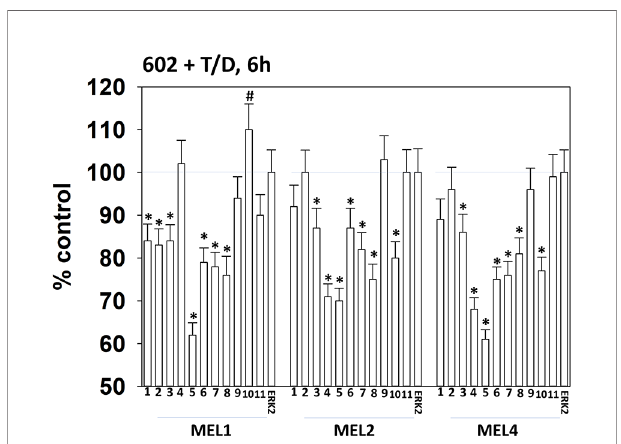
FIGURE 10 | Exposure of cells to [GZ17-6.02 + trametinib + dabrafenib] reduces the expression of multiple HDAC proteins. Melanoma cells were treated with vehicle control or [GZ17-6.02 [curcumin (2 µM) + isovanillin (37.2 µM) + harmine (4.5 µM)] + trametinib (t, 2 µM) + dabrafenib (d, 2 µM)] for 6h. Cells were fi xed in place and in-cell immunostaining performed to determine the expression of HDACs1-11 and total ERK2 as a loading control. (n = 3 +/-SD) *p < 0.05 less than vehicle control value. # Greater than vehicle